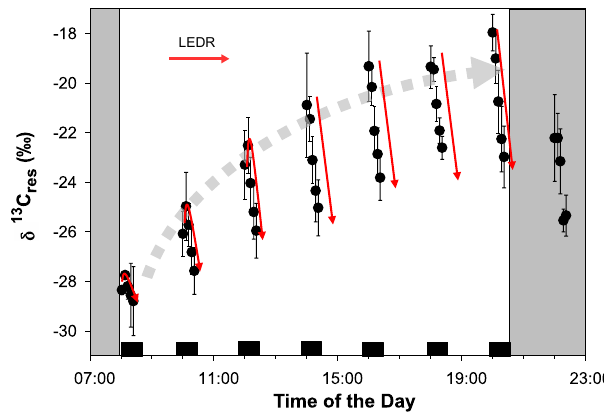
Fig. 4. Diel (grey dashed arrow) and short-term (red arrows) post- illumination changes of leaf dark respired δ 13 CO 2 ( δ 13 C res ) during 25min dark phases over the diurnal course (grey areas indicate the dark period). Black bars at the bottom of the figure represent the time during which the measured leaf was darkened, while the rest of the plant remained under the growth light conditions. Data are mean values of Quercus ilex leaves ( n = 3, ± SE), reprinted from Werner et al.